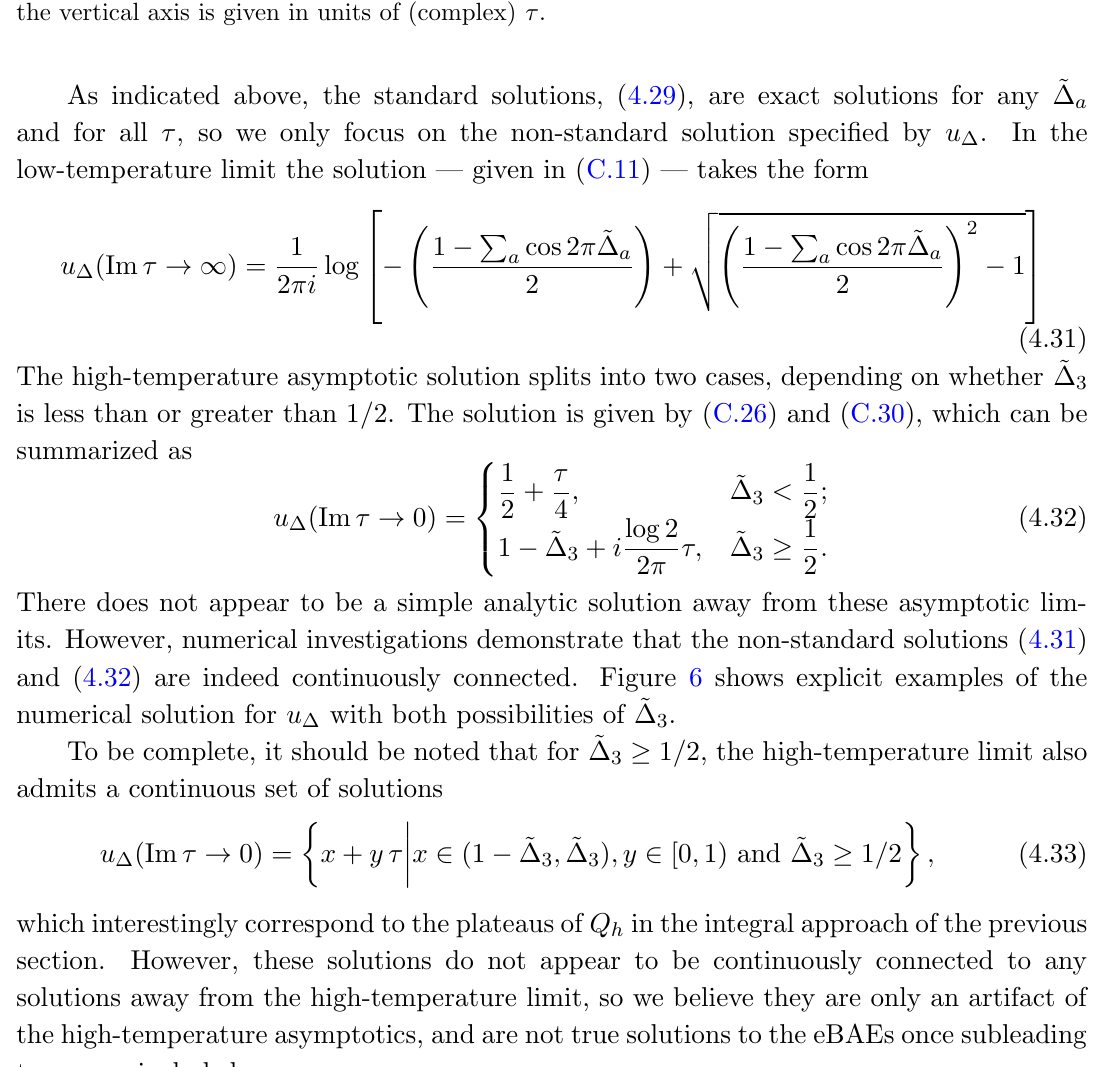
Figure 6. Numerical plots of the non-standard N = 2 solution u (cid:1) with arg( (cid:28) ) = (cid:25)= 4. The (cid:12)gure on the left corresponds to ~(cid:1) 3 < 1 = 2 while that on the right corresponds to ~(cid:1) 3 > 1 = 2. Note that the vertical axis is given in units of (complex) (cid:28)